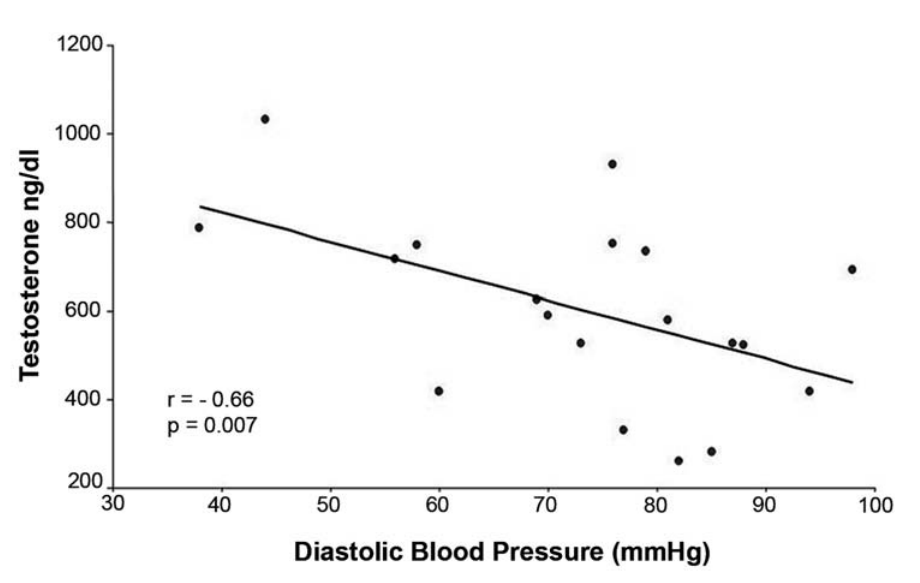
Figure 2 – Regression linear plots in all patients between total testosterone serum levels systemic diastolic blood pressure at the last minute of the 6 minutes walking